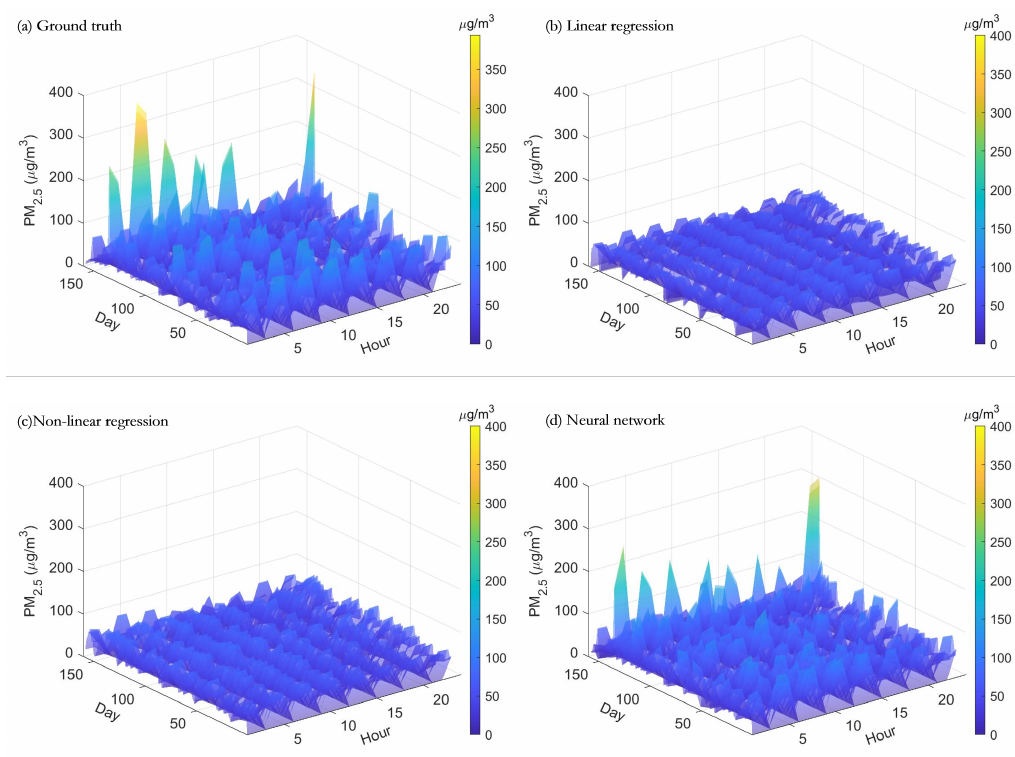
Figure 8. This figure shows comparisons of PM 2.5 concentrations estimated using different machine learning methods. Table 2. PM 2.5 prediction performances of three different models.